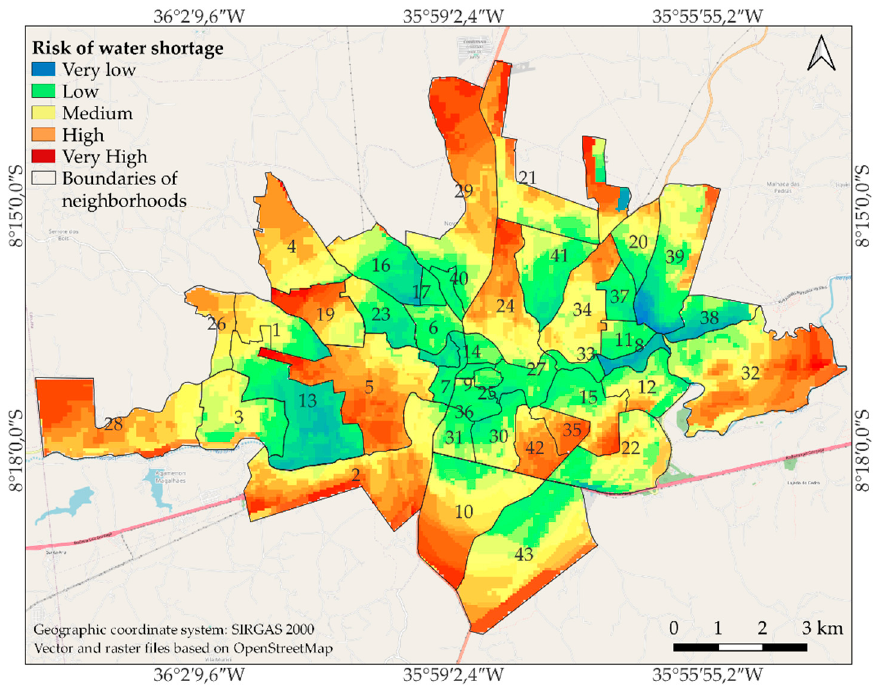
Figure 6. Mapping the risk of water shortages for the urban area of Caruaru, Pernambuco.